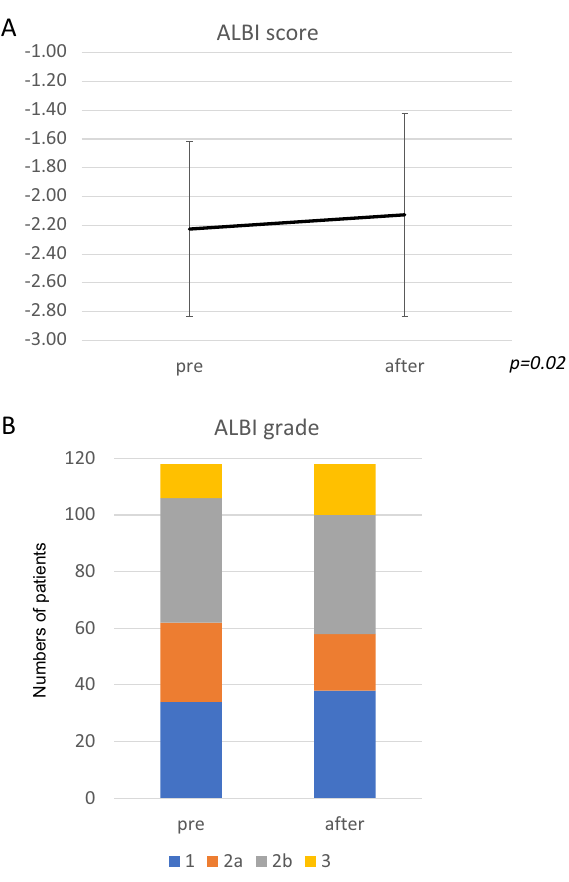
Figure 4. Analysis of liver functional reserve during Ultra-FP therapy. Albumin-bilirubin (ALBI) scores before and after 3 course of Ultra-FP therapy are shown ( A ). Y-axis indicates ALBI score. Error bars indicate standard deviation. The numbers of patients based on ALBI grade system at the pre-treatment and after 3 course of Ultra-FP therapy are shown ( B